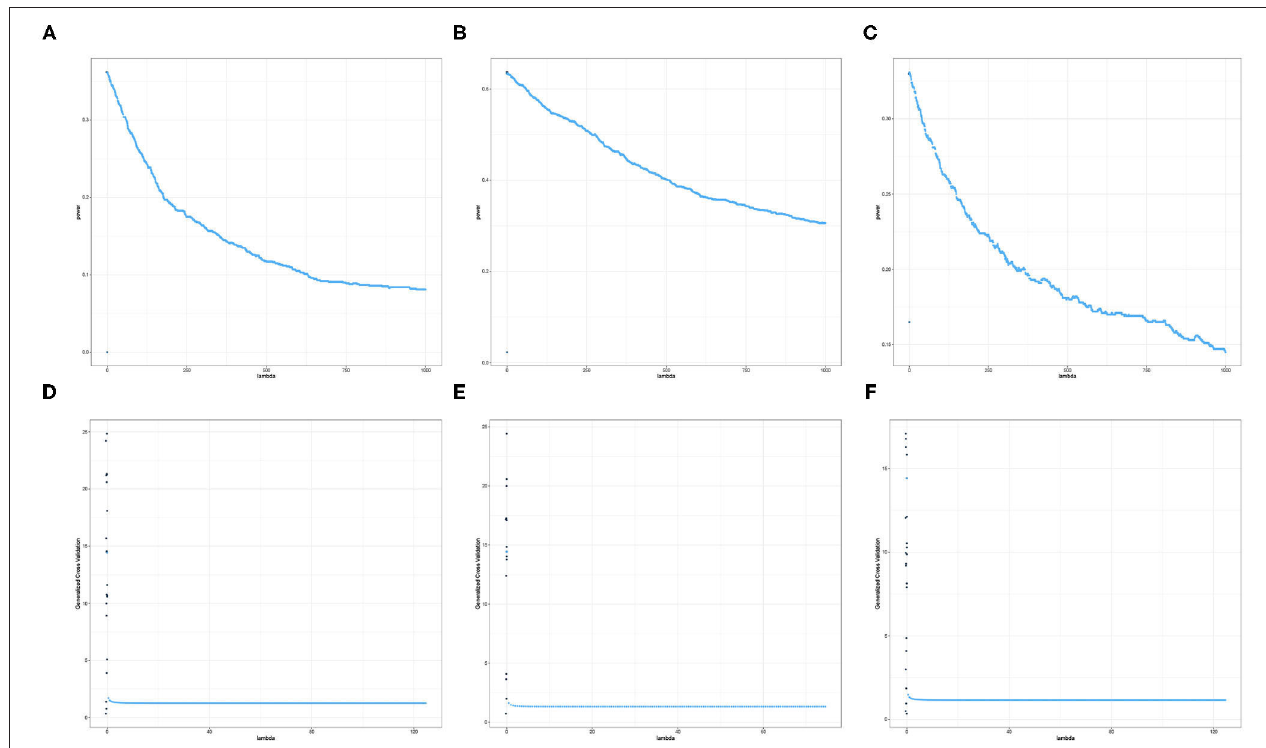
FIGURE 7 | Empirical Power and GCV plots of the Adaptive Mantel test for the imaging genetics data with n = 350 observations, p = 497 genetic features and coherence information from selected channel-channel-band triples with decreasing power trend. (A) Power: F3-FT8-beta. (B) Power: Iz-Oz-delta. (C) Power: CPz-AF4-delta. (D) GCV: F3-FT8-beta. (E) GCV: Iz-Oz-delta. (F) GCV: CPz-AF4-delta.